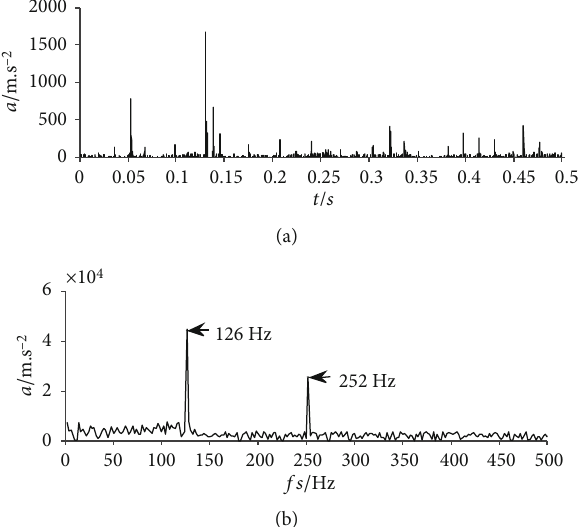
3 with an Figure 11: Waveform and frequency spectrum of bearing R an outer ring defect signal denoised by an adaptive multiscale combined morphological fi lter. (a) Waveform. (b) Frequency